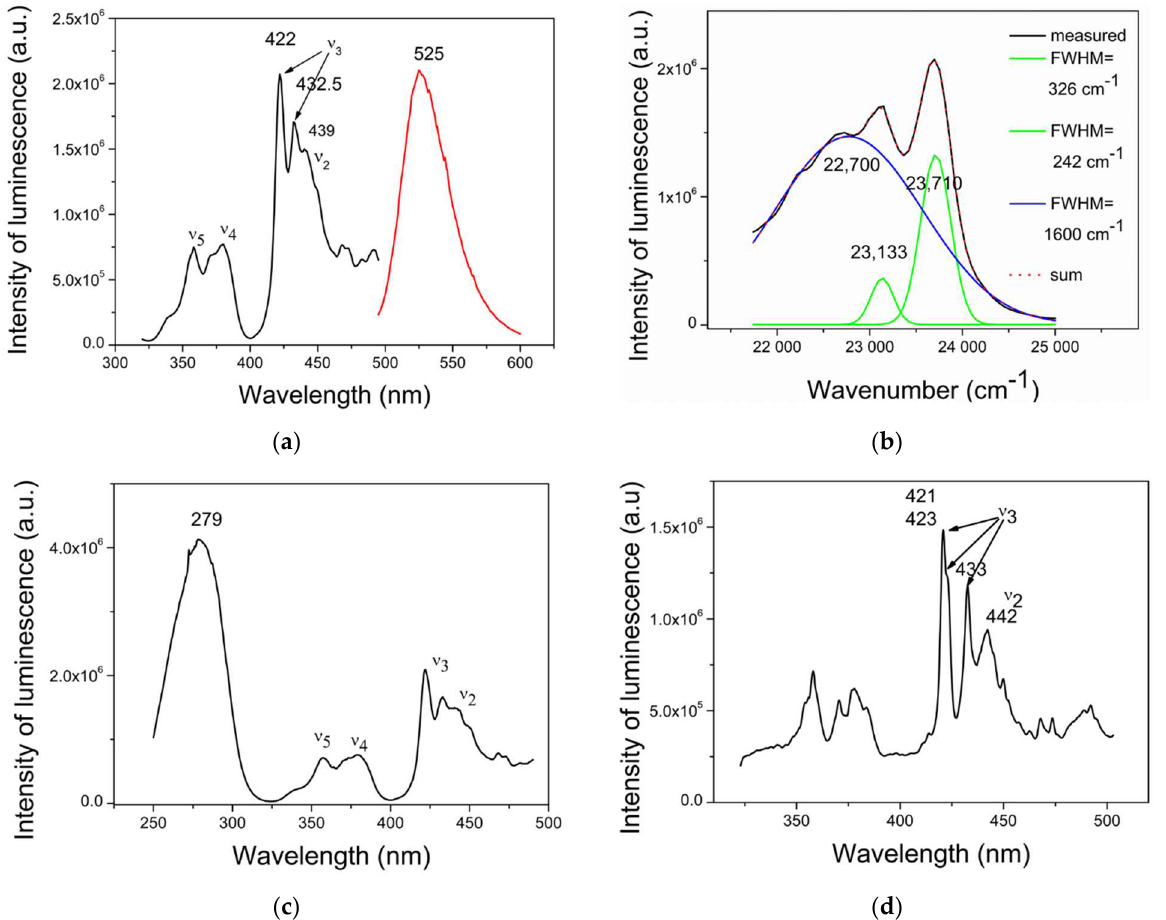
Figure 9. Luminescence spectra of willemite W2 sample: ( a ) emission (right) and excitation (left) of Mn 2+ measured at T = 300 K; ( b ) deconvolution of υ 2 and υ 3 bands; ( c ) excitation spectrum for λ = 525 nm—point defect to Mn 2+ energy transfer; ( d ) luminescence excitation spectrum measured at T = 77 K.